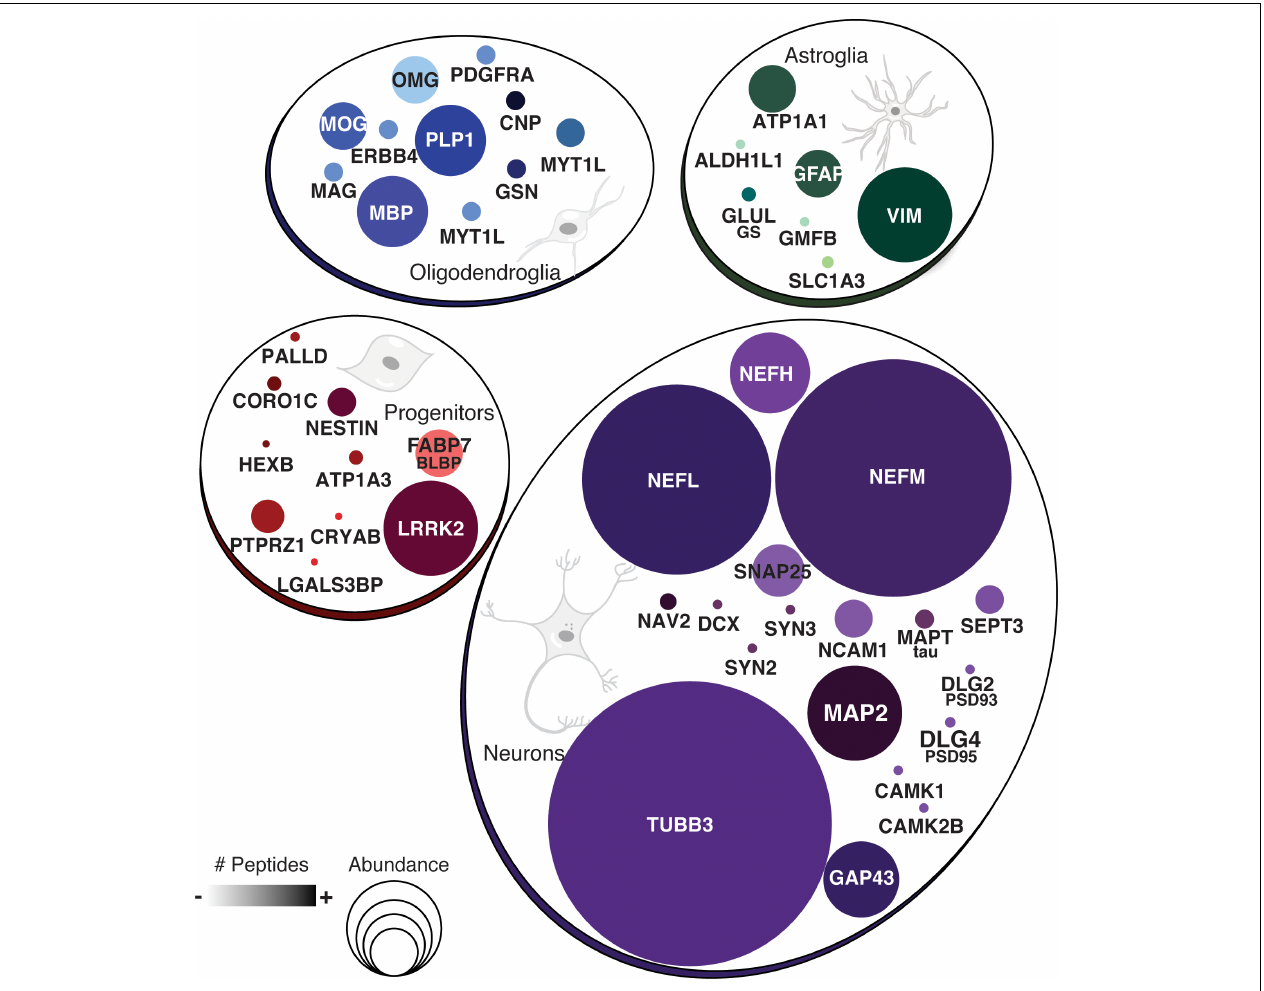
FIGURE 2 | Proteins commonly found in neural cell types. Groups show protein names representative of neurons, astroglia, oligodendroglia, or other progenitor cells. Circle sizes indicate the relative abundance of protein found. Color intensity is equivalent to the number of peptides found per